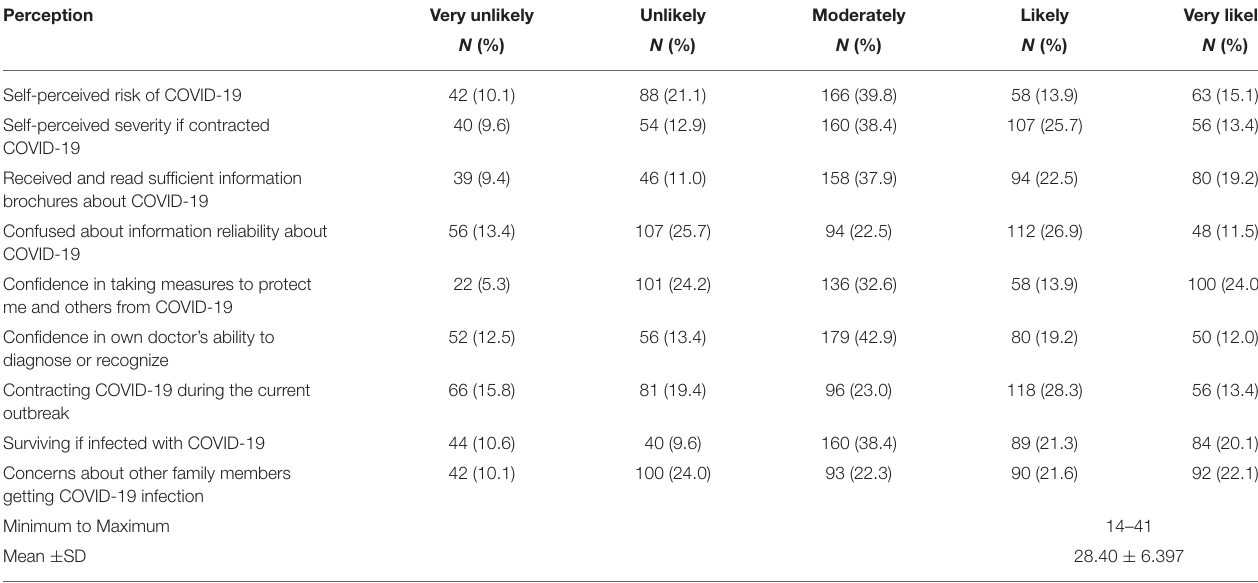
TABLE 2 | Perception toward COVID-19 pandemic among HCWs in North Shoa Zone health care facilities, Oromiya region, July 2020 ( n = 417). Perception Very